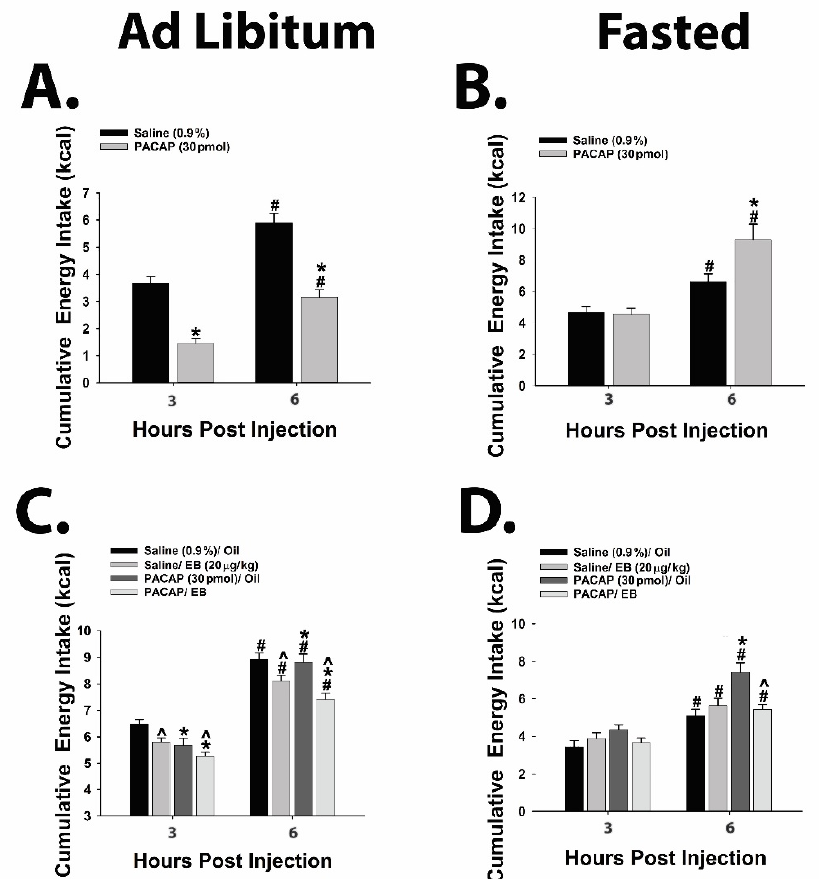
Figure 9. Fasting completely reverses the effect of a direct injection of PACAP into the ARC on energy intake, which is attenuated by EB in OVX females. Under ad libitum-fed conditions, PACAP (30pmo; n = 6l) significantly decreases cumulative energy intake in wildtype males compared to saline-treated controls (0.2 μ L; A ; n = 6). This PACAP-induced decrease in energy intake is no longer apparent in fasted males, and PACAP actually causes an increase in cumulative consumption which is evident at six hours post-administration ( B ; n = 7–9). PACAP also decreases energy intake in ad libitum-fed OVX wildtype females, and this effect is potentiated by EB (20 μ g/kg; s.c.; C ; n = 6). Again, the effect of PACAP on consummatory behavior in fasted OVX females is exactly the opposite of that seen under ad libitum conditions, as is the modulatory effect of EB ( D ; n = 6). Bars represent means and lines 1 S.E.M. of the cumulative energy intake seen in ad libitum-fed or fasted mice injected with either PACAP or its saline vehicle. #, p < 0.05 relative to cumulative energy intake seen at three hours after PACAP injection, repeated-measures, multi-factorial ANOVA/LSD; *, p < 0.05 relative to saline vehicle, repeated measures, multi-factorial ANOVA/LSD; ^, p < 0.05 relative to sesame oil vehicle, repeated measures, multi-factorial ANOVA/LSD. Figure adapted from [12].